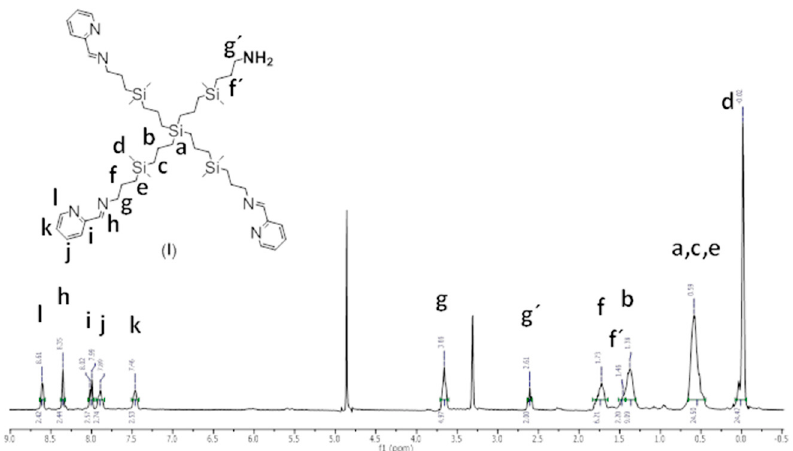
Figure 1. Synthesis of ruthenium-terminated carbosilane dendrimer with FITC (CRD13-FITC).